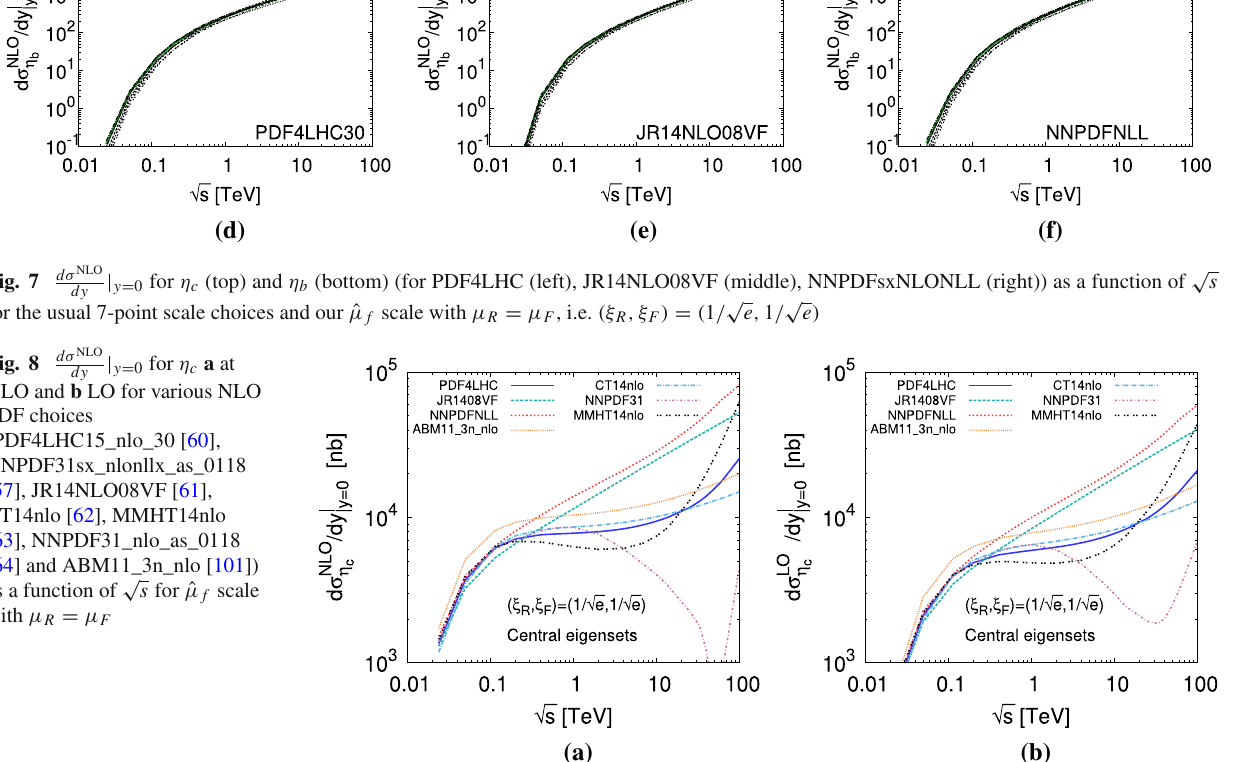
Fig.3whichallowedustoassessthemuchbetterconvergence of the NLO results at high energies when taking μ F = ˆ μ F